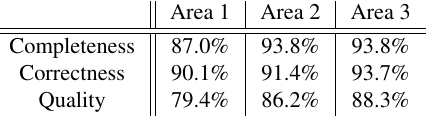
Table 3: Per-area accuracies of class building